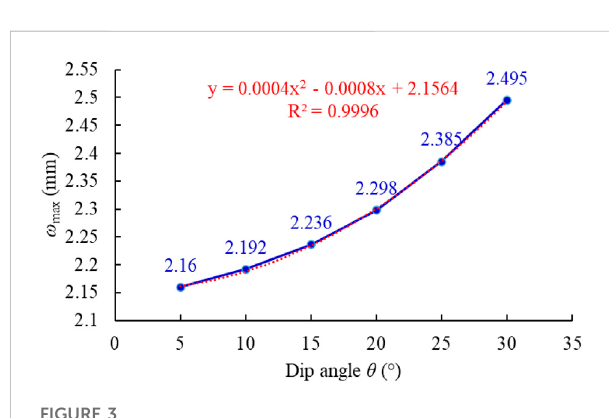
FIGURE 3 Variation characteristics of maximum roof de fl ection ω max .